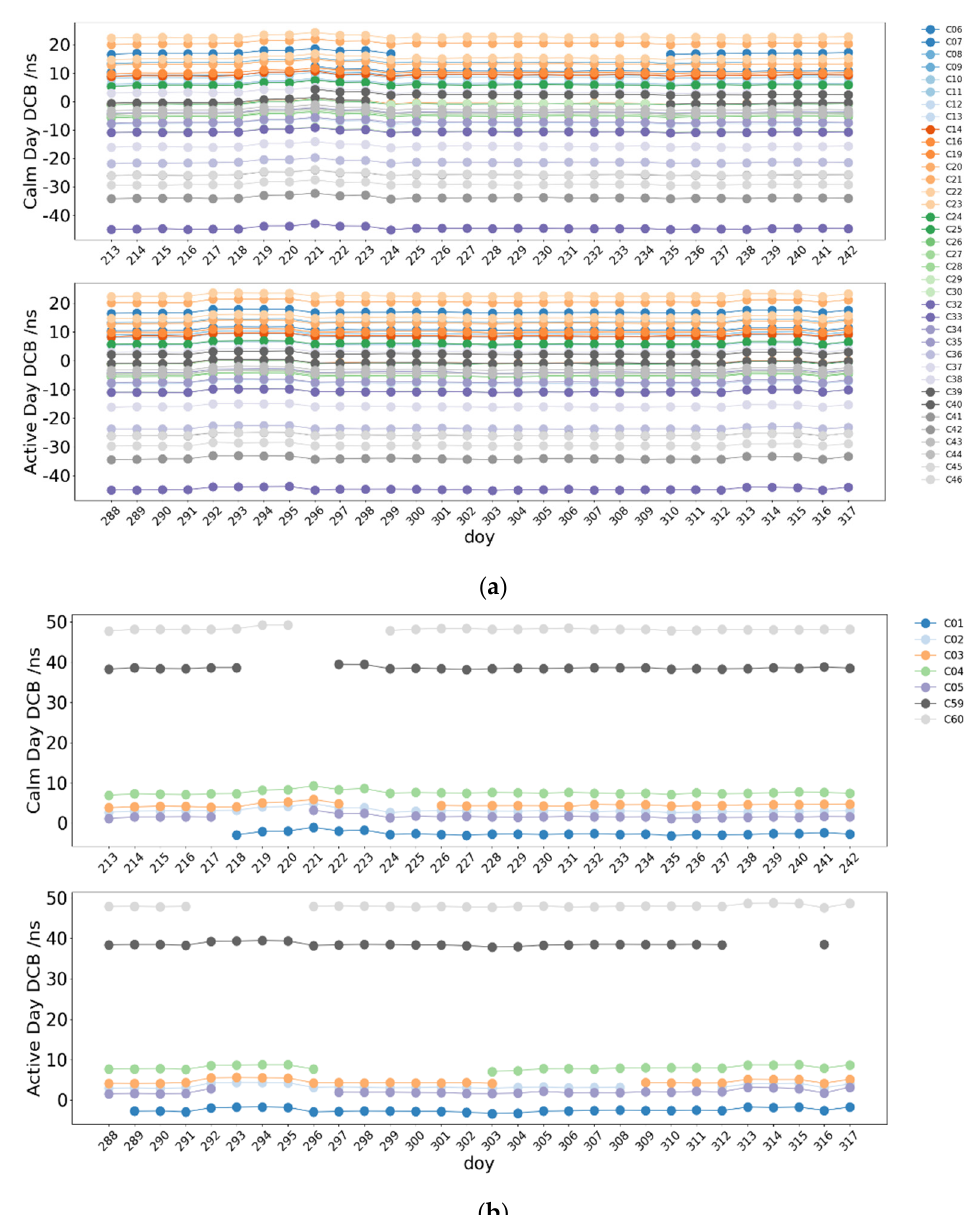
Figure 17. DCB time series of BDS satellites in different ionospheric conditions. ( a ) is BDS (MEO + IGSO) satellites and ( b ) is BDS GEO satellites.